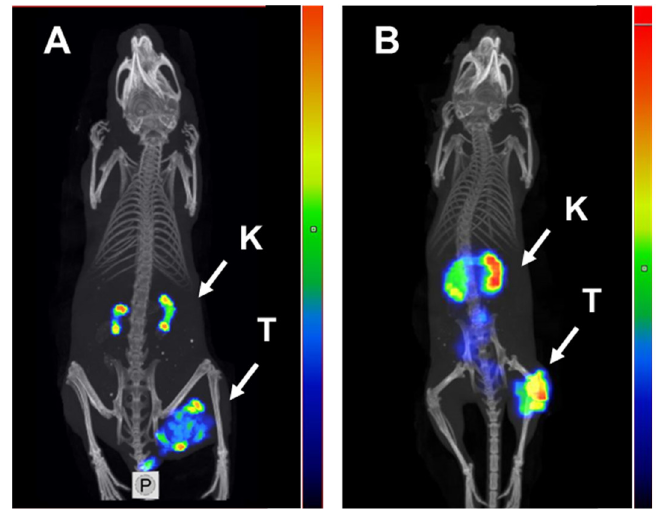
Figure 7. Micro-single photon emission computed tomography (SPECT) / CT imaging of EpCAM expression in Balb / c nu / nu mice bearing ( A ) OVCAR-3 and ( B ) SKOV-3 xenografts using [ 125 I]I-PIB-Ec1 6 h pi. K—kidneys, T—tumor.